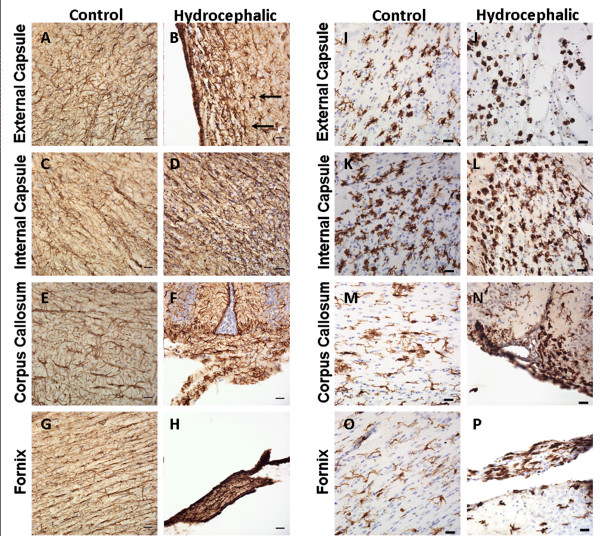
Representative photomicrographs of GFAP for astrocytes (A-H) and Iba-1 for microglia (I-P) immunohistochemistry from the external capsule, internal capsule, corpus callosum, and fornix in P11 saline control animals (A, C, E, G for GFAP; I, K, M, O for Iba-1) and hydrocephalic animals (B, D, F, H for GFAP; J, L, N, P for Iba-1). For GFAP, despite the immaturity of the tissue, the hydrocephalic animals exhibit the same severe glial reaction observed in the P22/23 animals as evidenced by large intensely stained cell bodies and thick processes (B, straight arrows). For Iba-1, note the round intensely stained profiles that represent highly phagocytic microglial somata in the white matter of control animals. These profiles are increased in hydrocephalic animals at this age, but are not found in any 22 or 23-day old animals. Scale bar = 25 μm and cresyl violet counterstain for all panels.